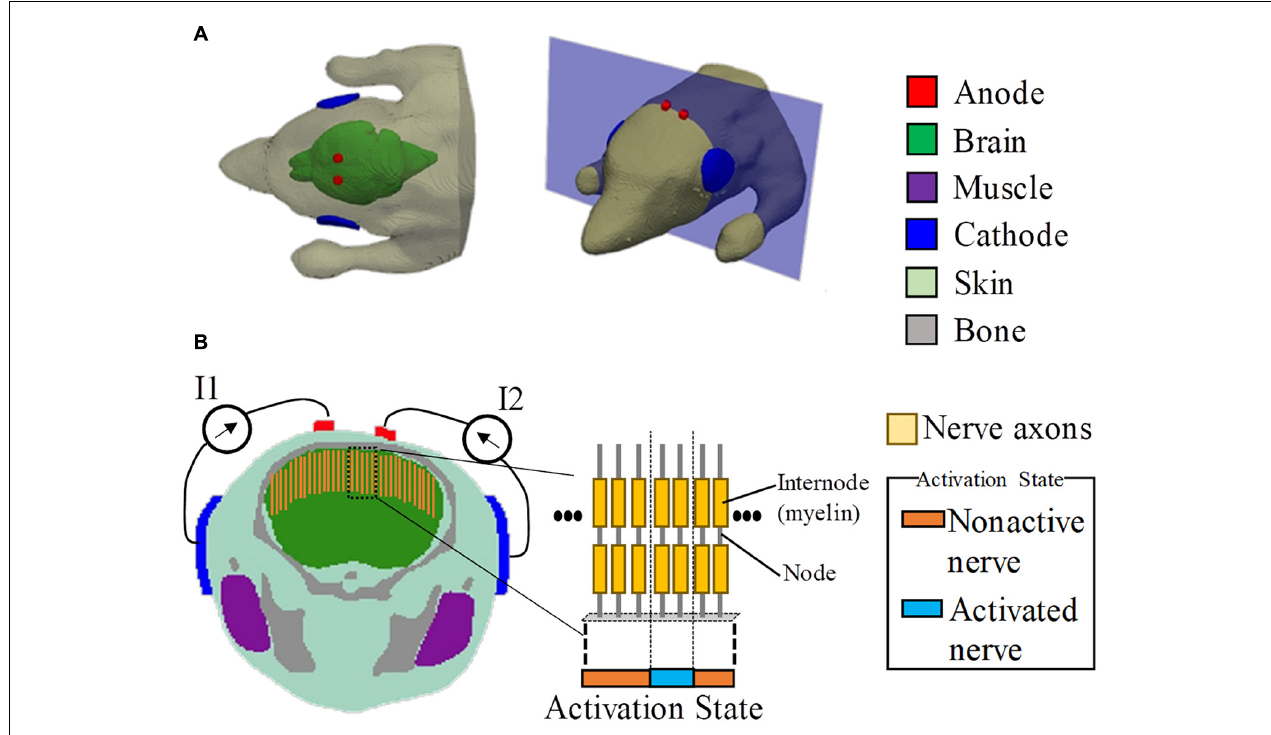
FIGURE 1 | Multiscale model for interferential transcranial alternate current stimulation. (A) Volume conductor of the mouse model with two pairs of electrodes attached on the scalp based on the experimental scenario in Grossman et al. (2017). (B) Cross-section showing the positions of the axonal nerves in the motor area of the brain (total number of test axons is 80). The activated nerves are depicted by an activation state region (1D).